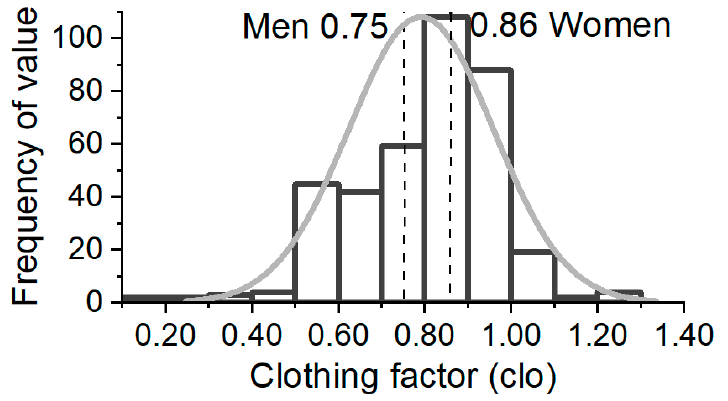
Figure 12. Clothing factor density function, frequency of value in surveys. Average values are displayed distinguishing genders.